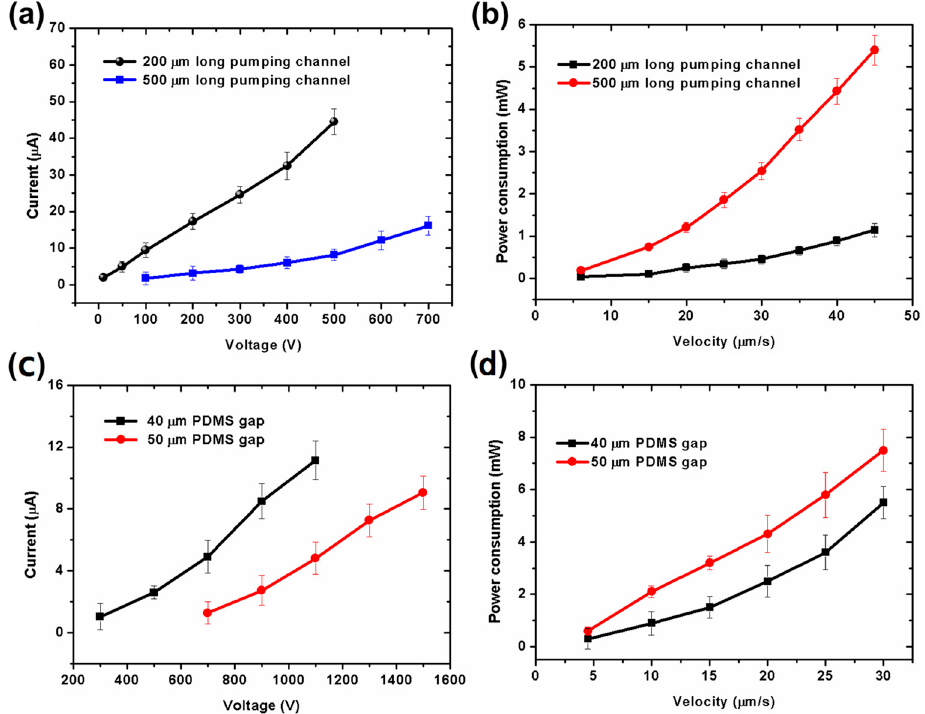
Figure 6. Experimental results of electric current through PDMS gap in a five-stage pump. ( a ) Current as a function of applied voltage with different pumping channel length; ( b ) Power consumption as a function of velocity with different pumping channel lengths. The pumping and connecting channels are all 20 µ m wide. The connecting channels are 1.4 times as long as the pumping channels. The PDMS gap between electrode and pumping channels is 20 µ m. The PDMS gap between adjacent two pumping channels is 20 µ m. The inlet and outlet channels are 2 mm long, 40 µ m wide. All channels are 20- µ m high; ( c ) Current as a function of applied voltage with different PDMS gaps between the electrode and pumping channels; ( d ) Power consumption as a function of velocity with different PDMS gaps between electrode and pumping channels. The length and width of pumping channels are 200 µ m, 40 µ m, respectively. The connecting channels are 280 µ m long, 40 µ m wide. The inlet and outlet channels are 2 mm long, 40 µ m wide. All channels are 20 µ m high. The PDMS gap between two adjacent pumping channels is equal to the width of the pumping channel.